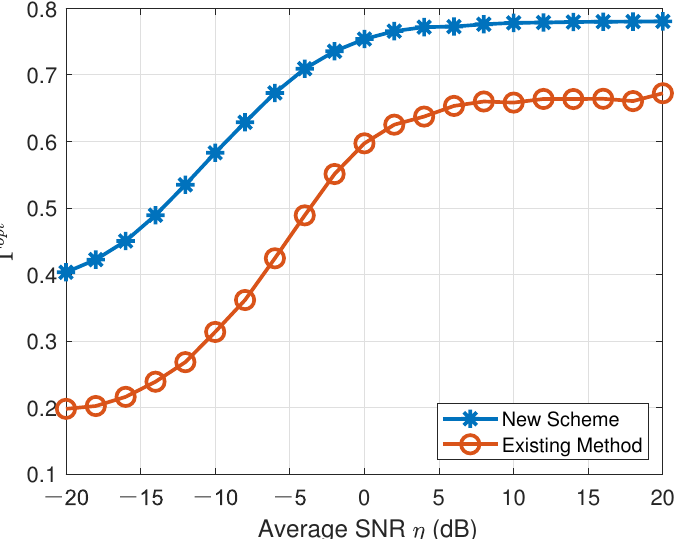
Figure 7. Comparison of Γ opt resulting from our proposed new CAMC scheme and the existing CAMC method in [23] based on LDA across twenty-one consecutive sensing